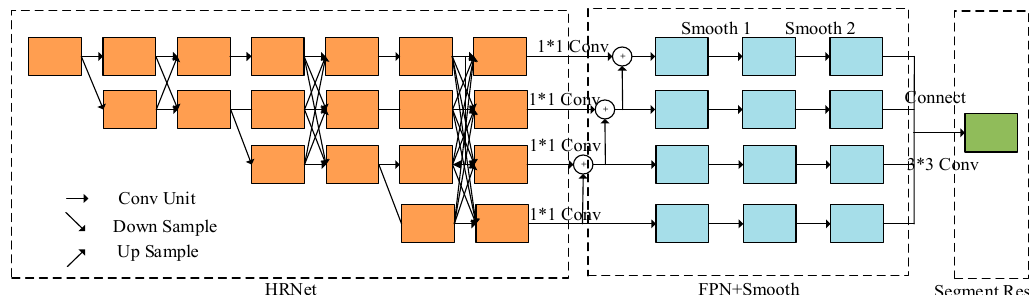
Figure 3. The structure of the global branch of GL-HRNet.